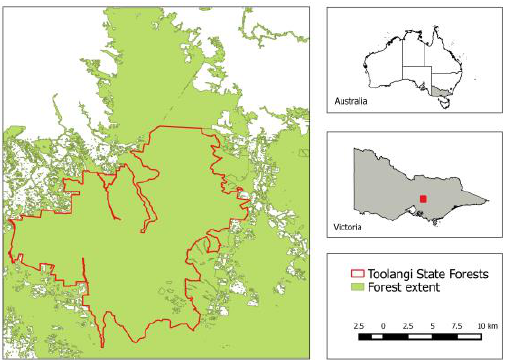
Figure1: Study area located in Central Highlands of Victoria, Australia.